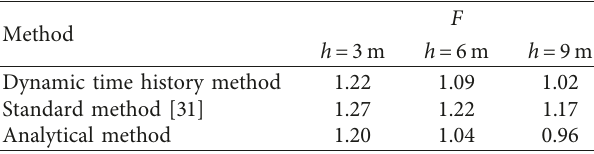
Table 2: Safety factor by different